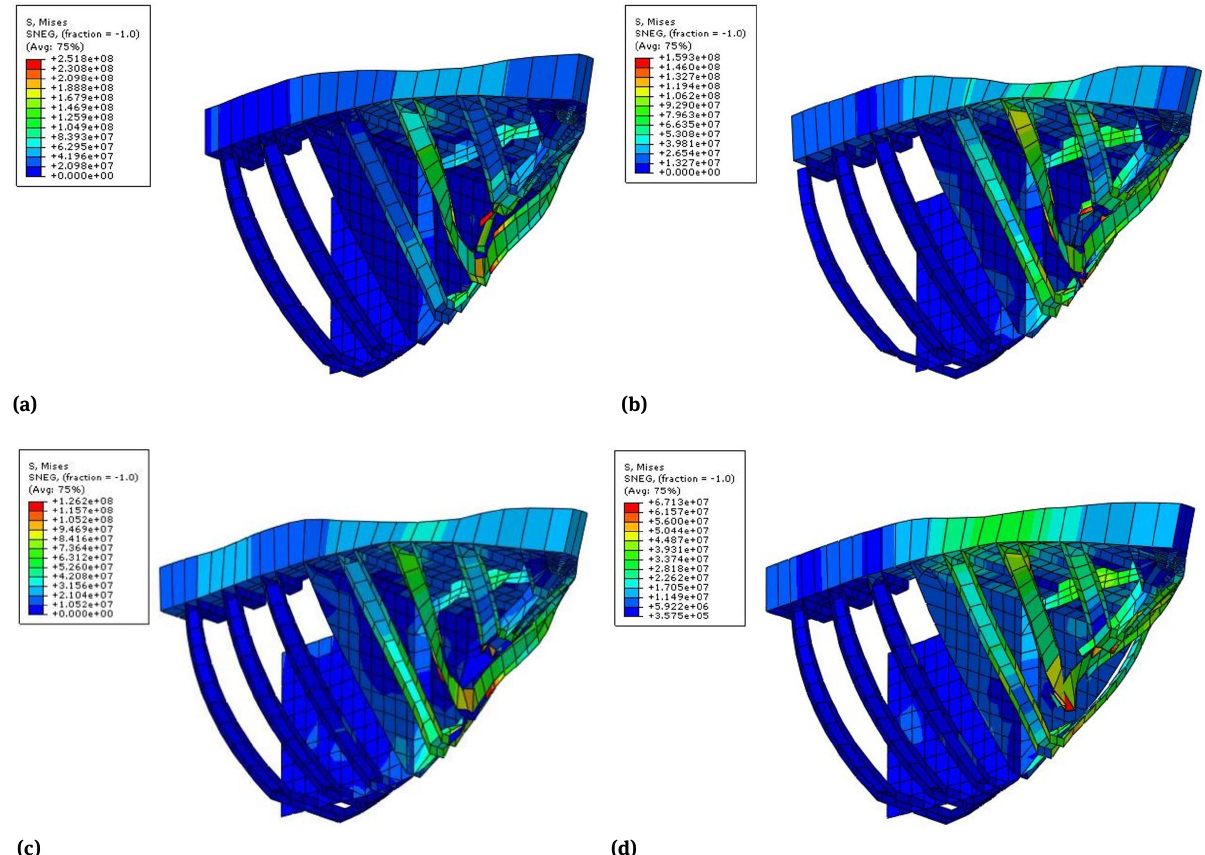
Figure 39: Deformation of bow construction due to impact at 5 knots: (a) Laminate type 1, (b) Laminate type 2, (c) Laminate type 3, (d) Laminate type